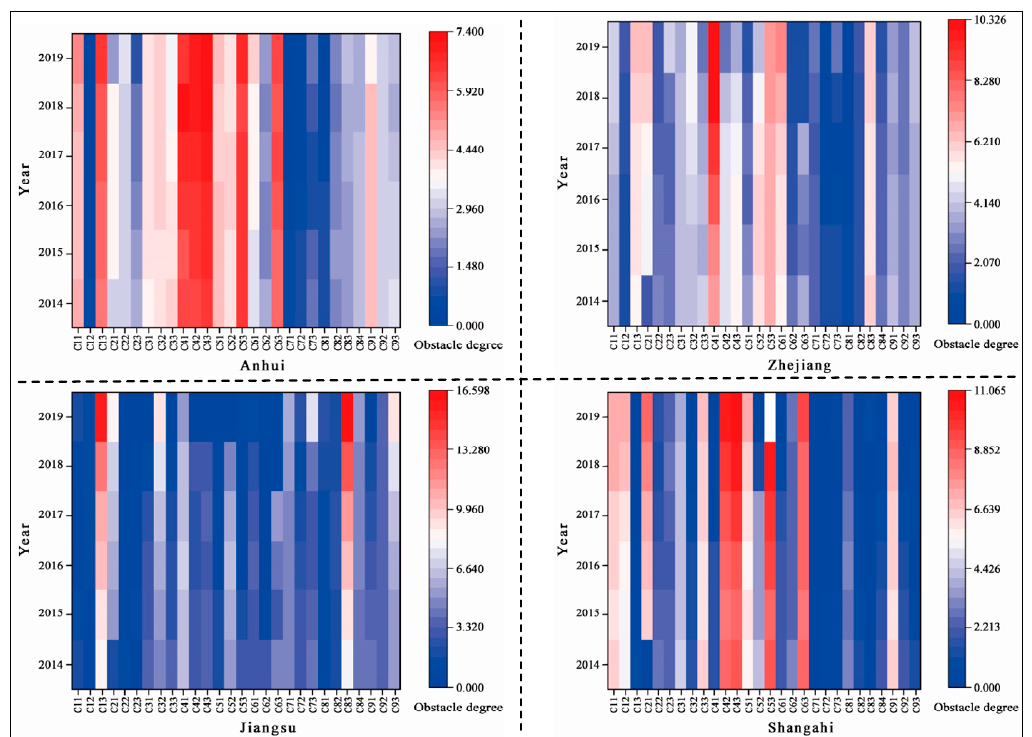
Figure 9. Changing trends in obstacle factors in the YRD region from 2014 to 2019.